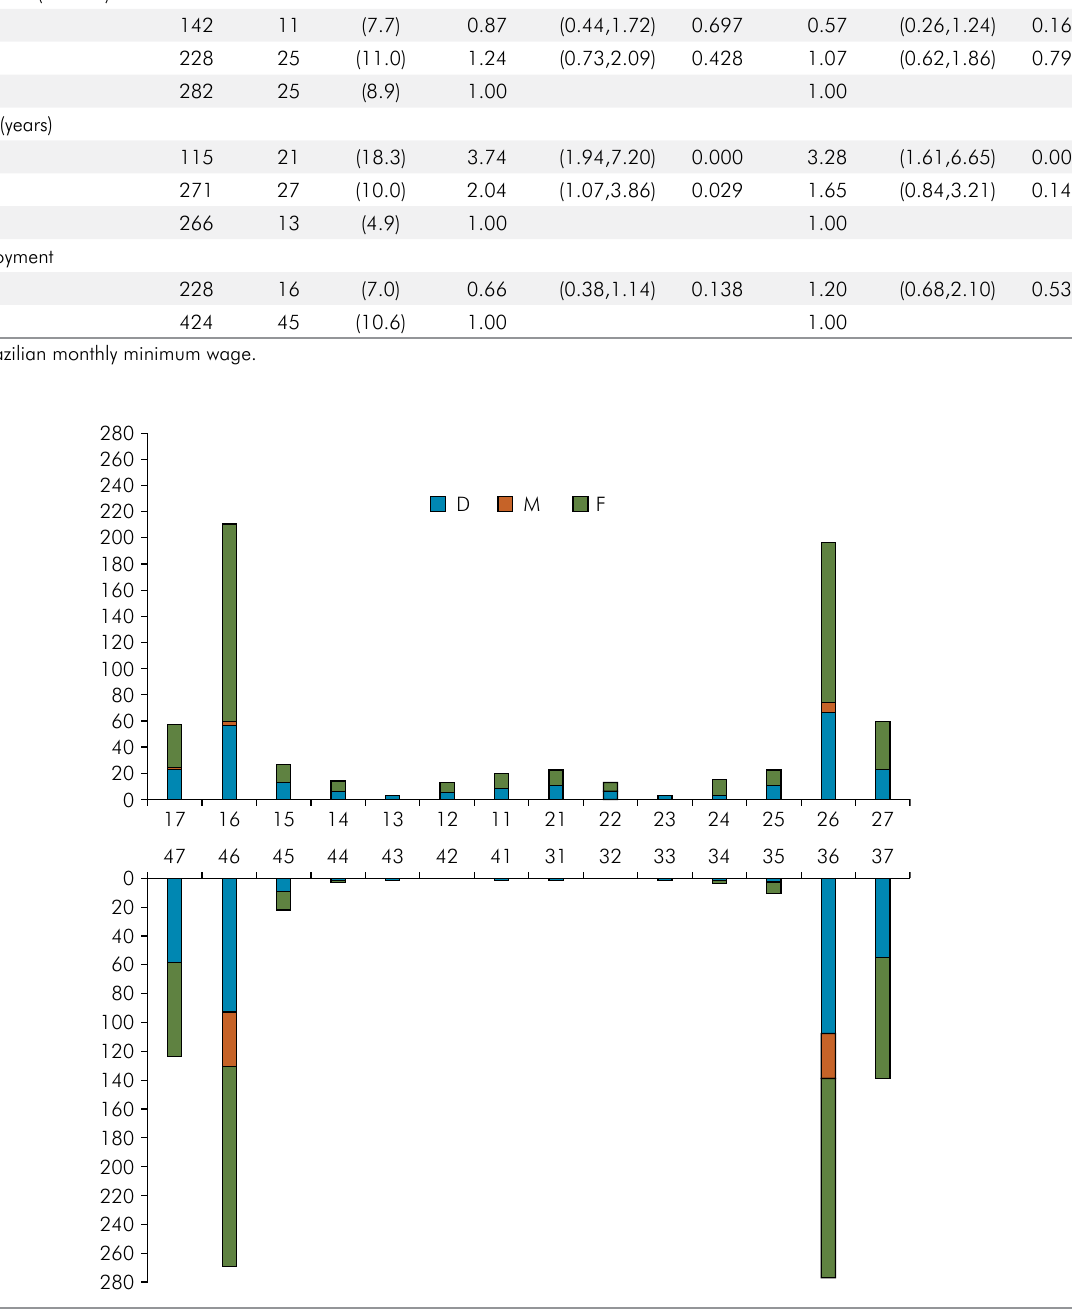
Figure. Distribution of caries experience per